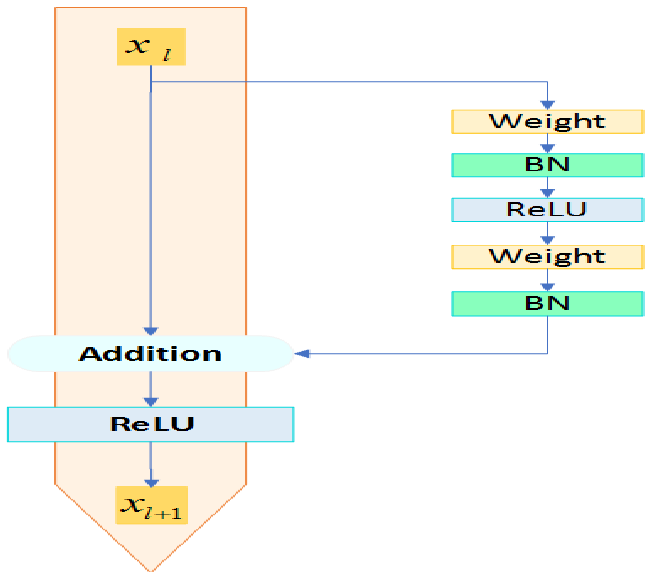
Figure 5. Original residual